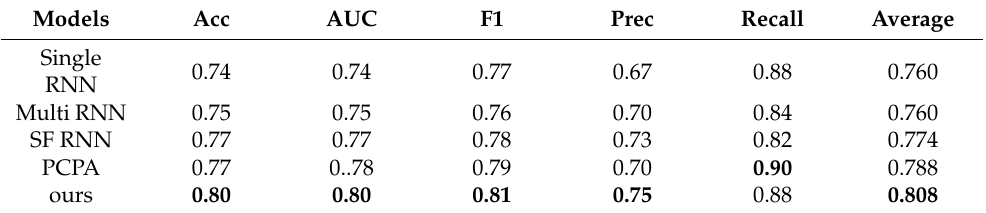
Table 2. The prediction results of each model on pedestrian crossing behavior under 8 frames (0.53 s) observation time and 24 frames (1.6 s) TTP. The evaluation index of the algorithm consists of accuracy, area under curve (AUC), F1 parameter, accuracy, recall and average